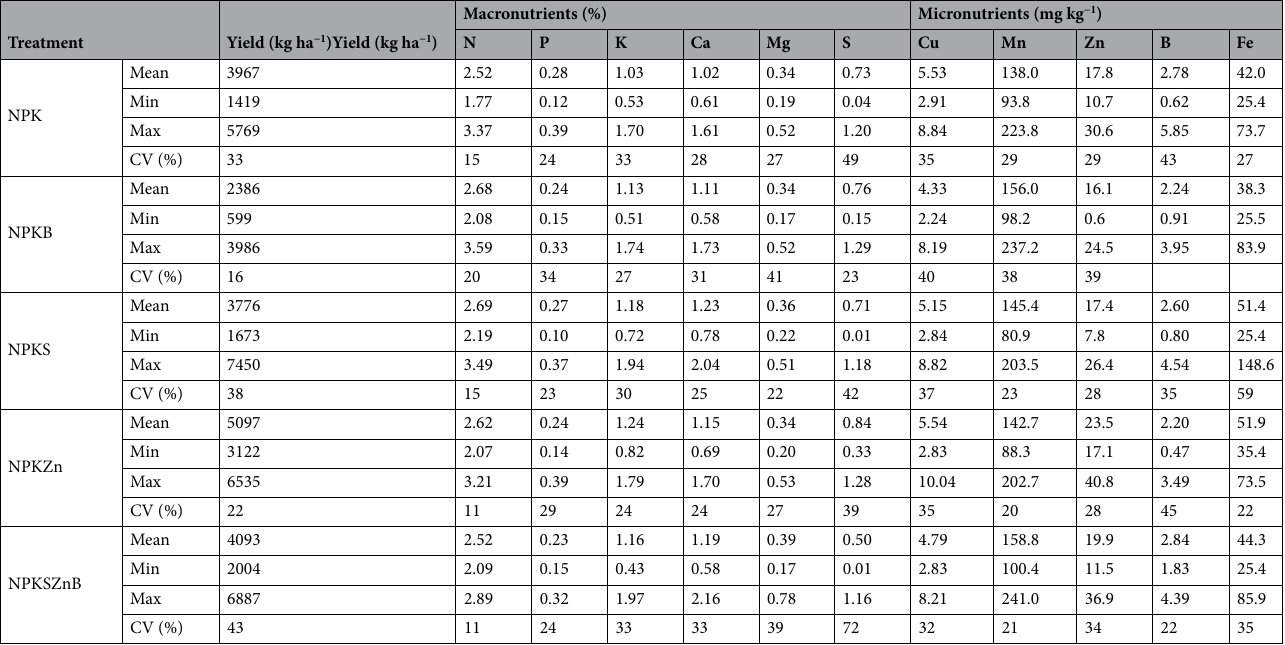
Table 3. Range of maize grain yield and ear leaf concentrations of macronutrients and micronutrients of fertilizer